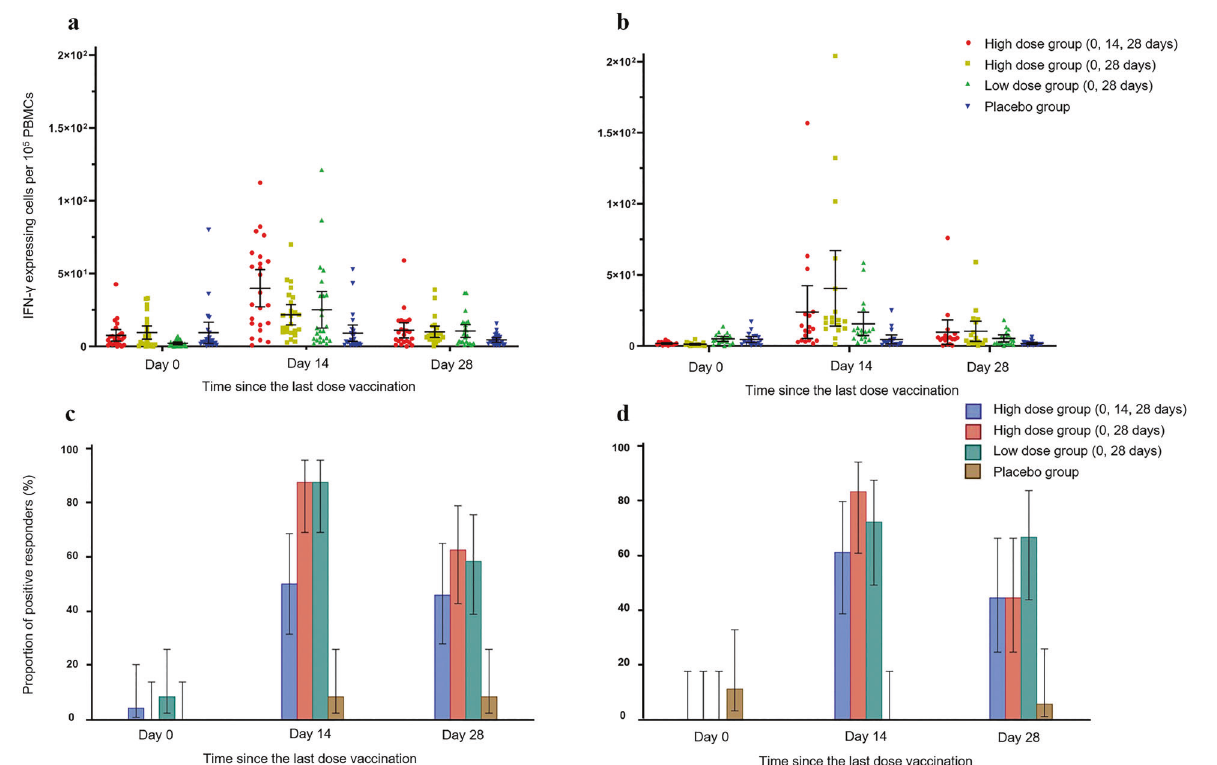
Fig. 2 Speci fi c T-cell response measured by ELISpot in phase 1 trial. In phase 1 trial, level of IFN- γ was detected by ELISpot before the fi rst dose vaccination, 14 and 28 days after the last dose vaccination ( a , b ), and then the positive rate of IFN- γ was calculated ( c , d ). Data are presented as mean and 95% CI. a , c : Adult group. b , d : Elderly